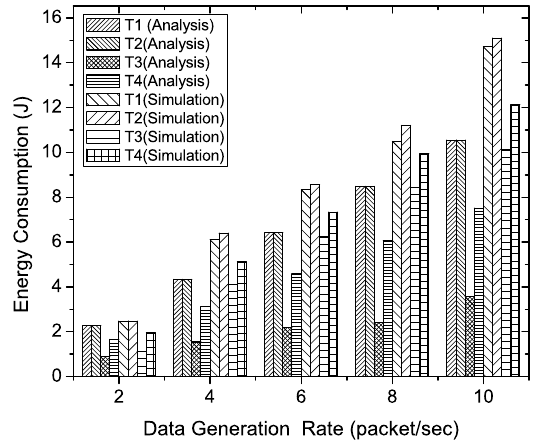
Figure 14. Comparison of energy consumption of diverse traffic types in analysis and simulation for different data generation